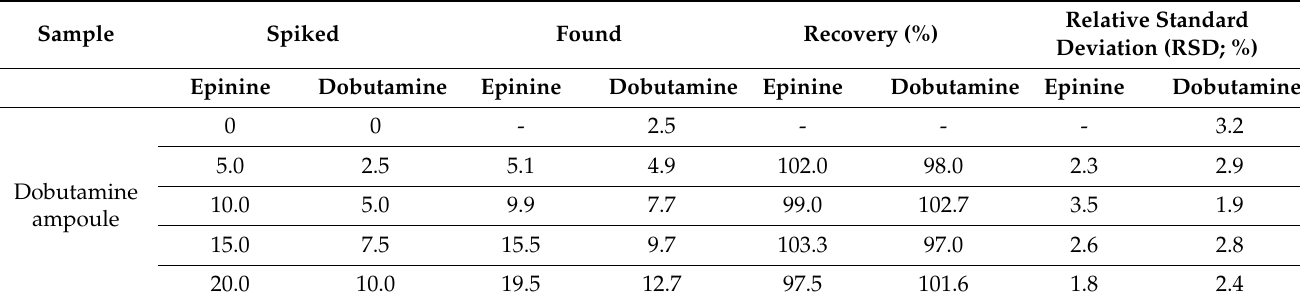
Table 2. Determination of epinine and dobutamine in real samples. All the concentrations are in µ M (n =